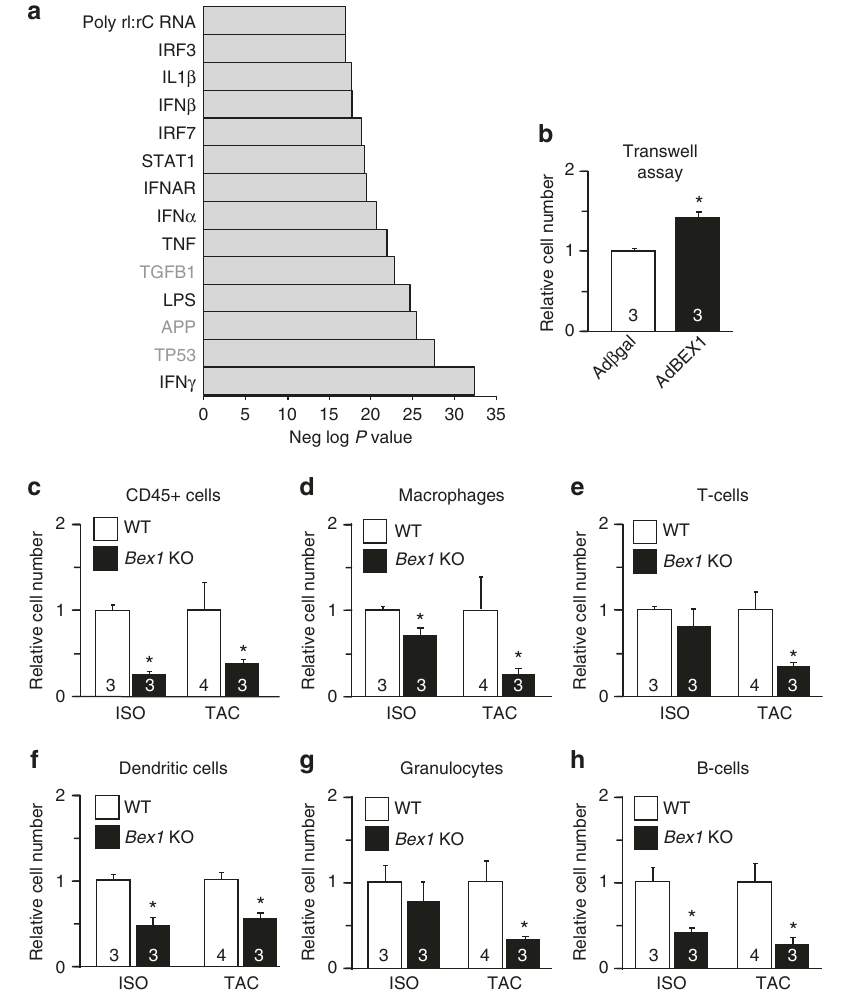
Fig. 4 BEX1 regulates proin fl ammatory mRNAs. a Ingenuity pathway analysis of RNA-seq from neonatal rat cardiomyocytes overexpressing BEX1 compared to β -galactosidase-overexpressing control (adenoviral mediated). Abbreviations: IFN γ (interferon- γ ); TP53 (tumour suppressor p53); APP (amyloid precursor protein); LPS (lipopolysaccharide); TGF β 1 (transforming growth factor- β 1); TNF (tumour necrosis factor); IFN α (interferon- α ); IFNAR (interferon α / β receptor); STAT1 (signal transducer and activator of transcription 1); IRF7 (interferon response factor 7); IFN β (interferon β ); IL1 β (interleukin-1 β ); IRF3 (interferon response factor 3); poly rI:rC RNA (polyriboinosinic acid and polyribocytidylic acid RNA). b Trans-well migration assay of immune cells attracted by neonatal rat cardiomyocytes overexpressing BEX1 compared vs. β -galactosidase-overexpressing control. c – h Quanti fi cation of the type of immune cell shown from the mouse heart following isoproterenol infusion (ISO) or pressure overload stimulation (TAC) by FACS using antibodies against CD45 (CD45 + cells), CD11b/MAC1 (Macrophages), CD3e (T-cells), CD11c (Dendritic cells), Ly6G (Granulocytes) and CD45R/B220 (B-cells). * P < 0.05 vs. WT. P value is unpaired 2-tailed t test. Number of mouse hearts analyzed is shown in the bars of each graph. All error bars represent